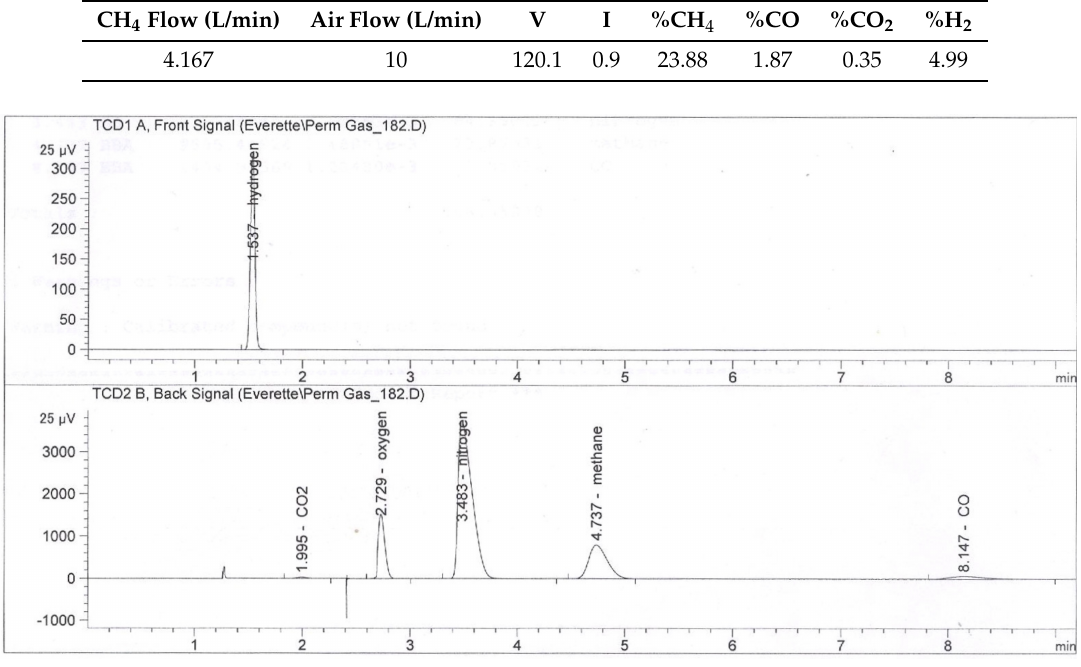
Figure 4. GC compositions